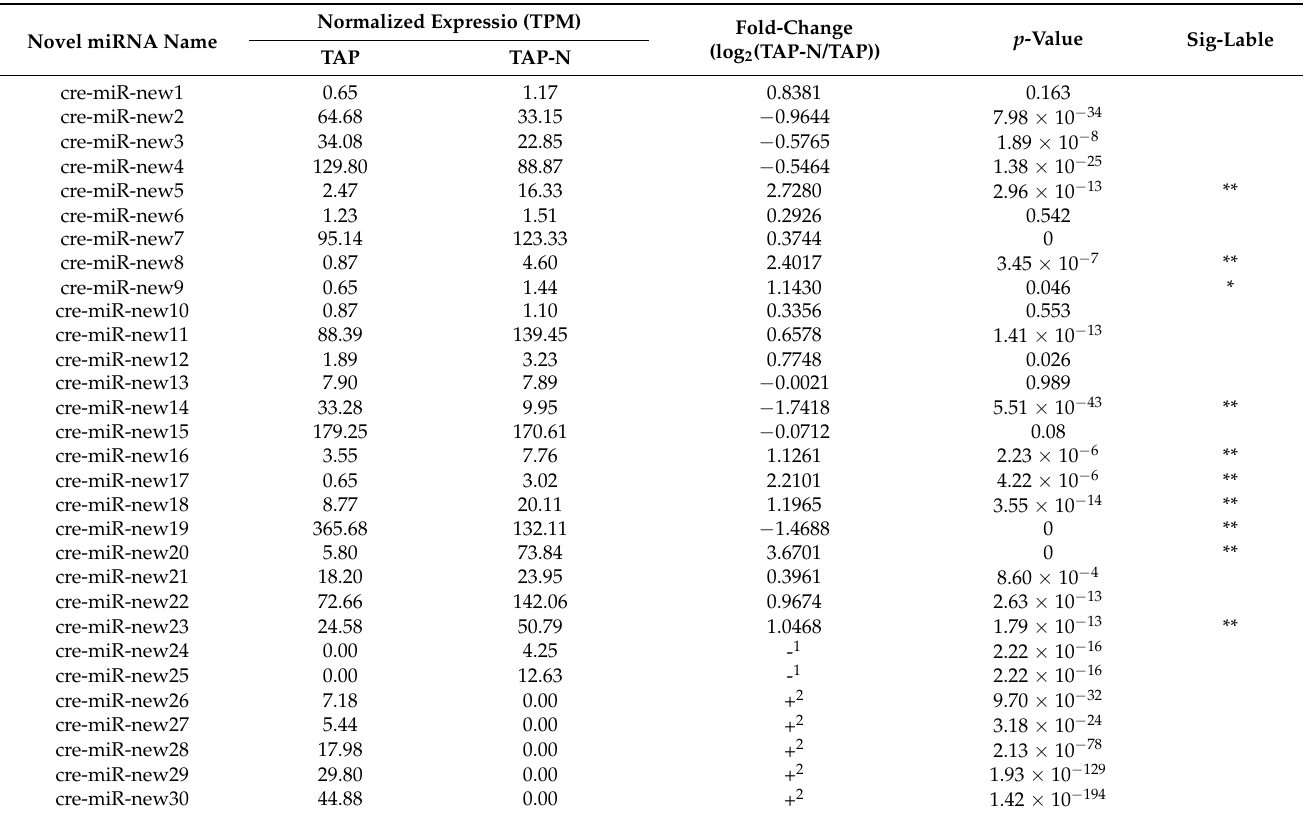
Table 2. Expression changes of predict novel miRNAs in response to nitrogen deprivation stress in C. reinhardtii . TAP represents normalized expression level of novel miRNAs of C. reinhardtii cultivated in nitrogen-replete medium; TAP-N represents normalized expression level of novel miRNAs of C. reinhardtii cultivated in nitrogen-depleted medium; * fold- change (log 2 ) > 1 or fold-change (log 2 ) < − 1, and 0.01 < p -value < 0.05; ** fold-change (log 2 ) > 1 or fold-change (log 2 ) < − 1, and p -value < 0.01; - 1 specifically expressed in TAP-N library; + 2 specifically expressed in TAP library.